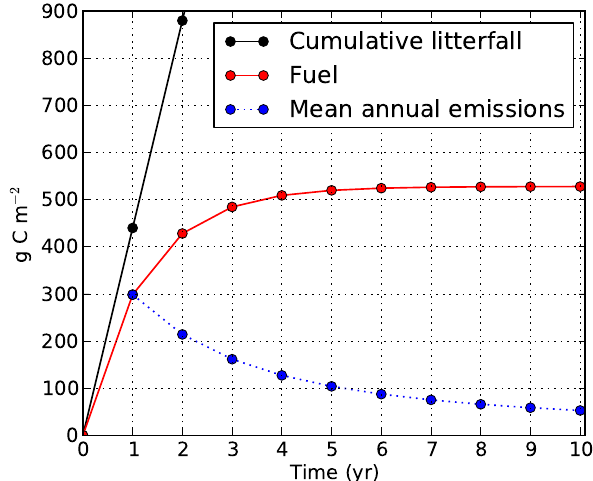
Fig. 6. Litterfall, fuel build-up, and corresponding mean annual emissions as predicted by the Olson equation (Eq. 1) for a site with 800gCm − 2 yr − 1 of NPP of which 55% is available to grow above- ground biomass. The graph shows the first ten years after a fire, and we assumed no aboveground biomass was left on the site after the fire that burned in year zero. Mean annual emissions were calcu- lated by dividing the amount of fuel in that year (red dot) by the number of years since fire. After a fire in a given year (which would correspond to the fire return time), the amount of fuel would be reset to zero.